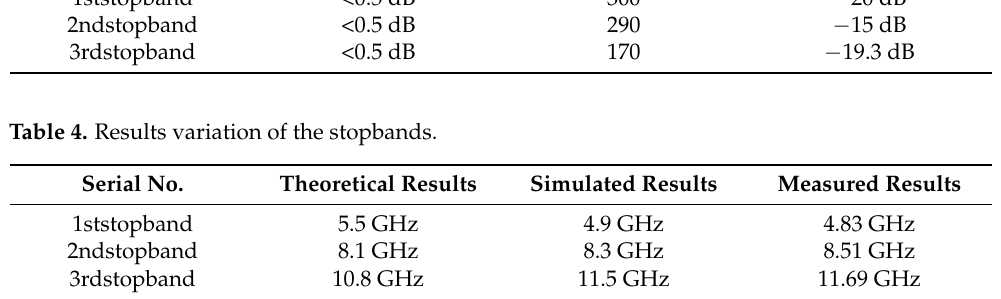
Table 4. Results variation of the stopbands.